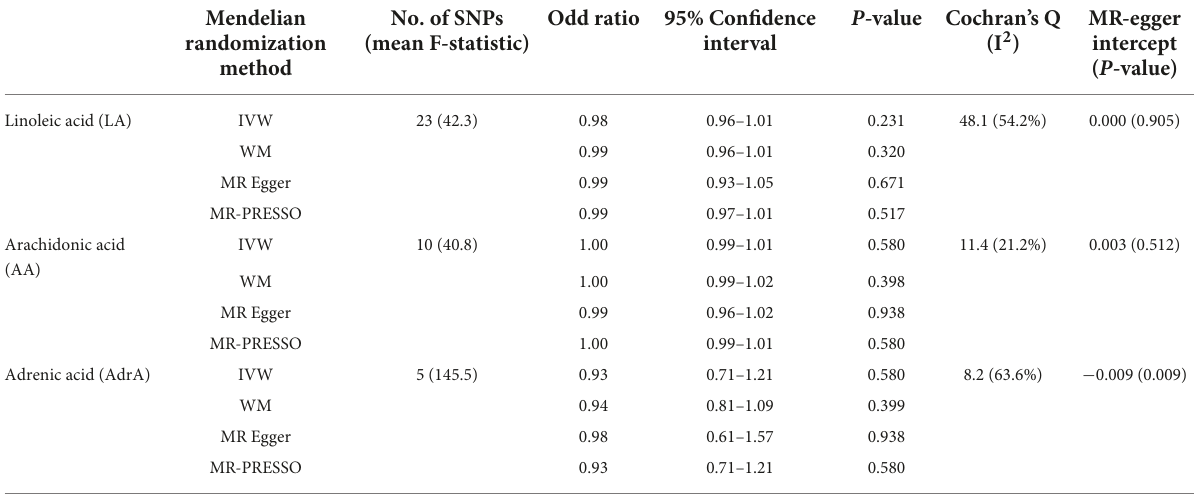
TABLE 2 Mendelian randomization (MR) estimates of causality between plasma omega-6 polyunsaturated fatty acids and sleep